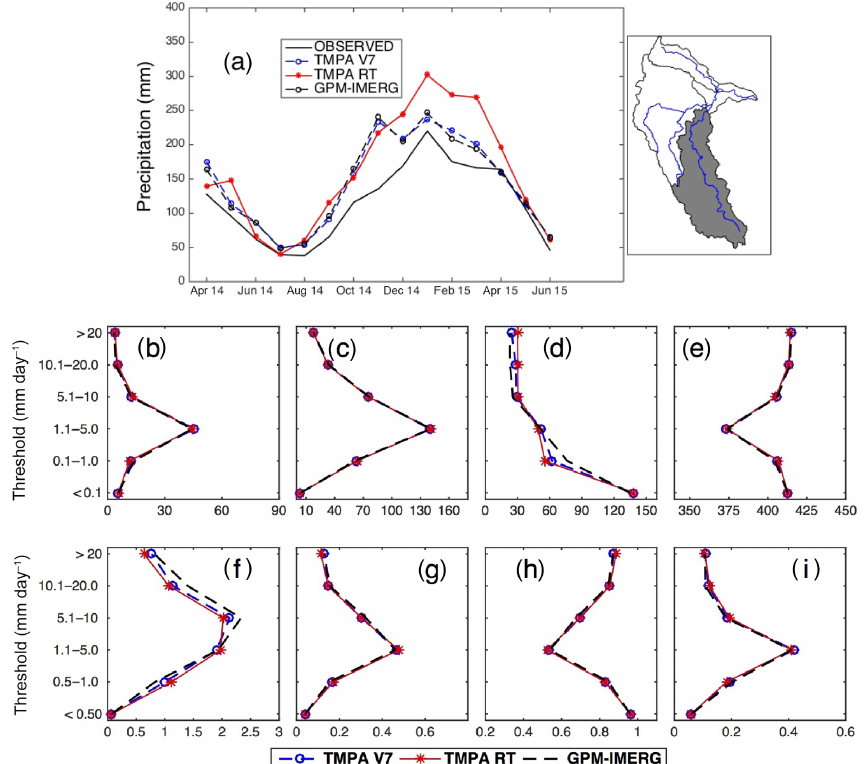
Figure 2. (a) Basin-average monthly rainfall for each precipitation dataset in the Ucayali Basin up to Requena station, (b) the number of observed rain events correctly detected, (c) the number of observed rain events not correctly detected, (d) the number of rain events detected but not observed (false alarms), (e) the sum of cases when neither observed nor detected rain events occurred, (f) coefficient frequency bias index (FBI), (g) probability of detection (POD), (h) false alarm ratio (FAR) and (i) equitable threat score